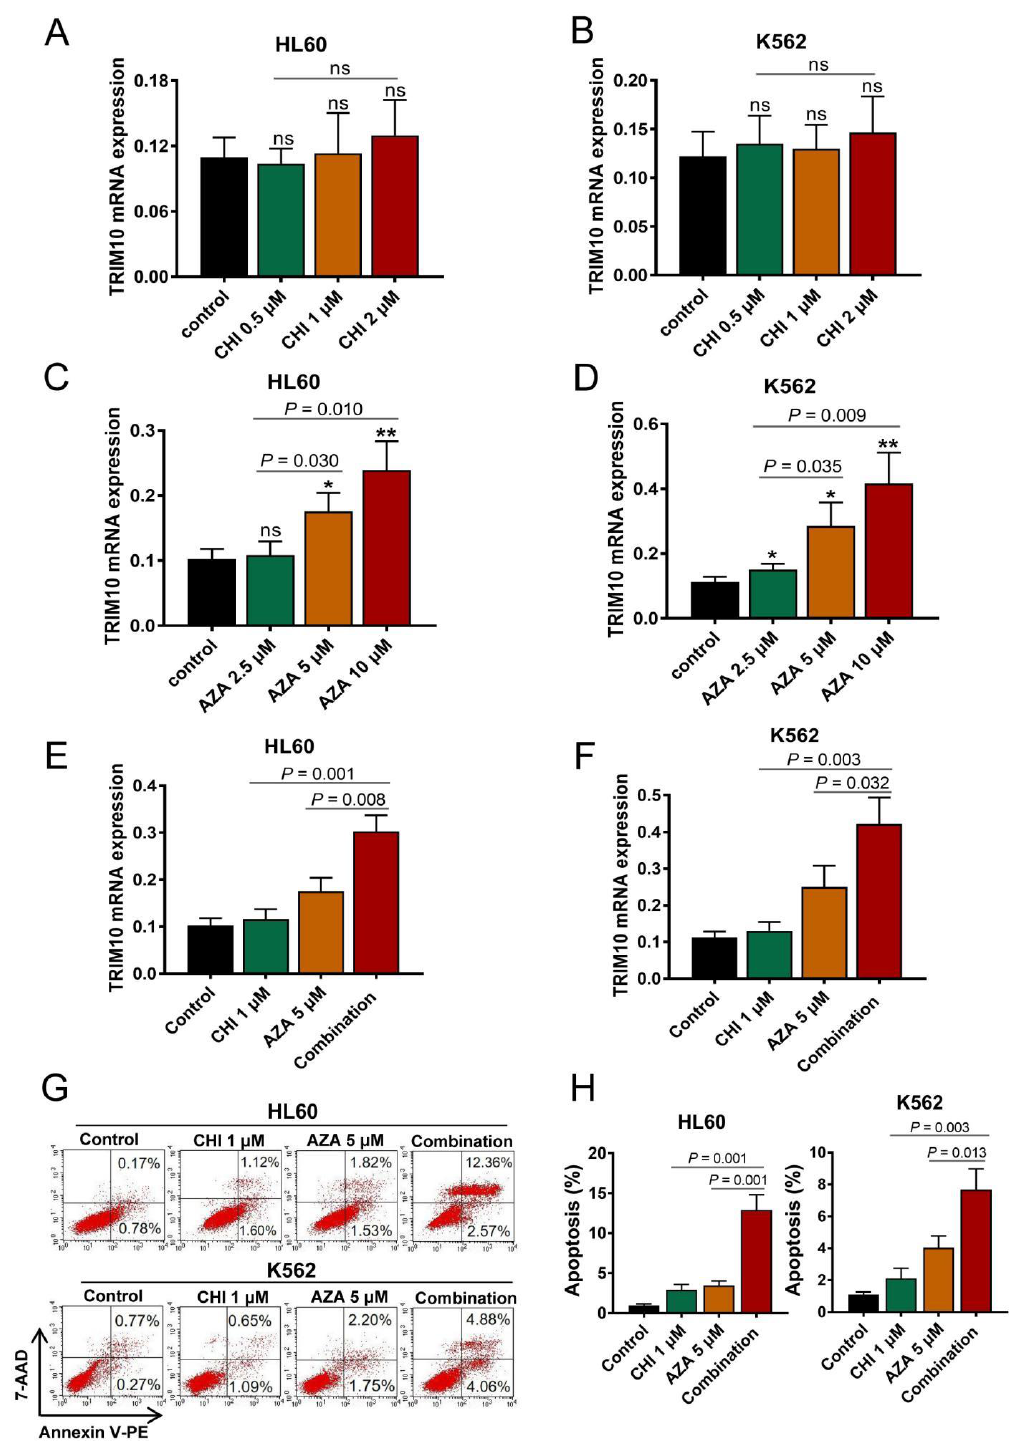
Figure 6. Combination of azacitidine (AZA) and chidamide (CHI) results in upregulation of TRIM10 expression and remarkable apoptosis in AML cells. ( A , B ) qRT-PCR analysis of TRIM10 expression after treatment with different dose of CHI for 48 h. ( C , D ) qRT-PCR analysis of TRIM10 expression after treatment with different doses of azacitidine for 48 h. ( E , F ) qRT-PCR analysis of TRIM10 expression after treatment with 5 µ M azacitidine and 1 µ M chidamide singly or in combination for 48 h. ( G , H ) Annexin V-PE/7-AAD double staining analysis of HL60 and K562 cells treated with 5 µ M azacitidine and/or 1 µ M chidamide for 48 h. Percentages of AML cell apoptosis based on three independent experiments. * p < 0.05; ** p < 0.01 (Student’s t